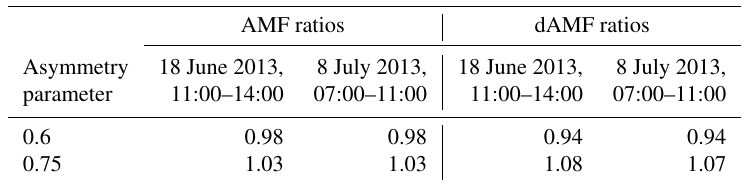
Table A8. Average ratios of O 4 (d)AMFs simulated for different aerosol phase functions (HG parameterisation with different asymmetry parameters (AP) vs. the results for the standard settings (asymmetry parameter of 0.68) for the middle period on each selected day.